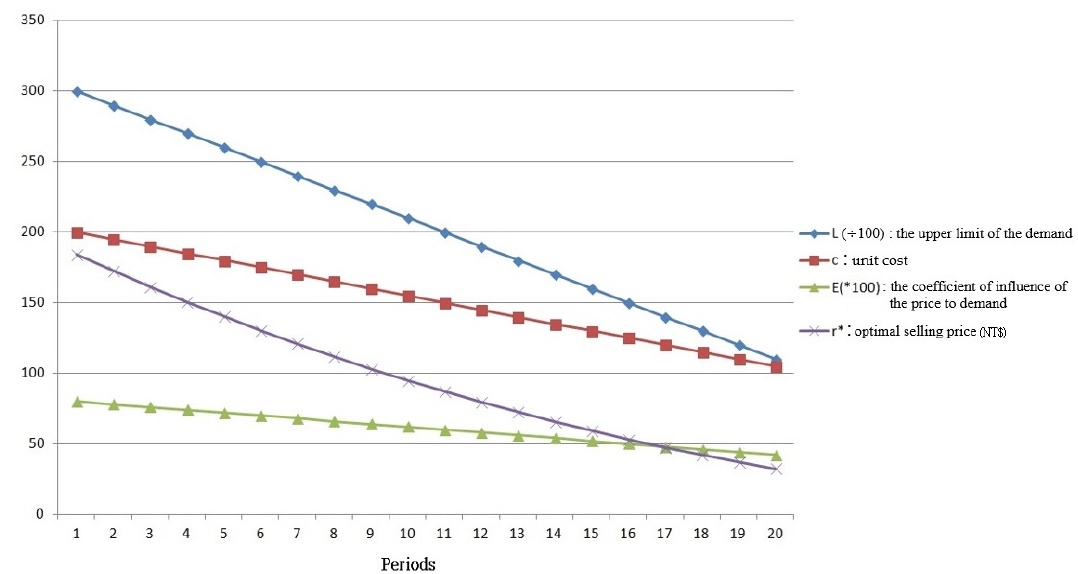
Figure 4. Influence of relevant parameters on the selling price of online group purchases.